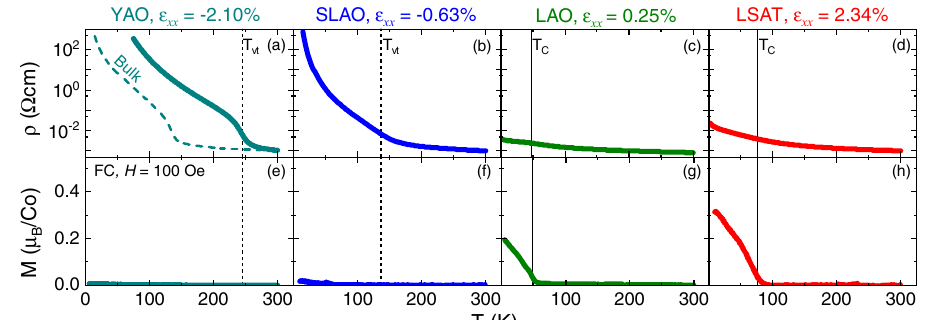
Fig. 3 | Strain-dependent electronic and magnetic properties of (Pr 0.85 Y 0.15 ) 0.7 Ca 0.3 CoO 3- δ fi lms. Temperature( T )dependenceoftheresistivity( ρ ) (toppanels,log 10 scale,takenonwarming)andmagnetization( M )(bottompanels) of 28- to 33-unit-cell-thick (Pr 0.85 Y 0.15 ) 0.7 Ca 0.3 CoO 3- δ fi lms on ( a,e ) YAO(101), ( b,f ) SLAO(001), ( c,g ) LAO(001), and ( d,h ) LSAT(001) substrates. (In ( a ), a bulk poly- crystallinesampleatthesamecompositionisshownforreference(dashedcurve)).